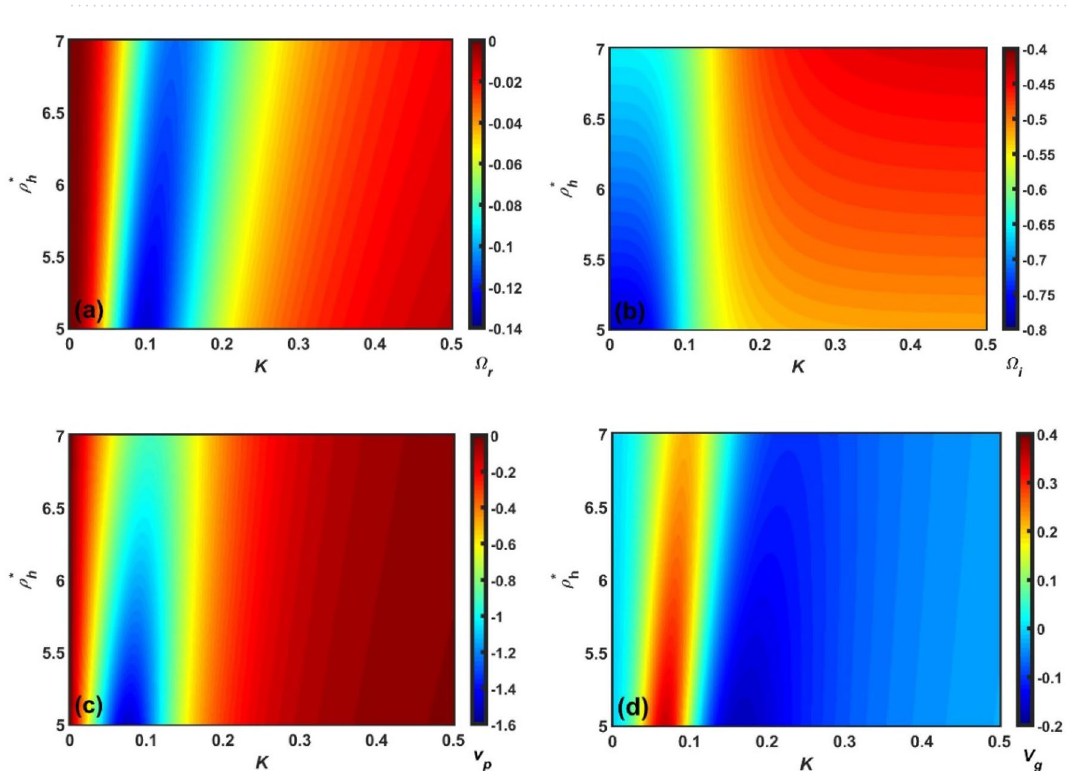
Figure 4. Same as Fig. 1, but for ρ h 0 normalized radial space coordinates as ξ dotted line), respectively.